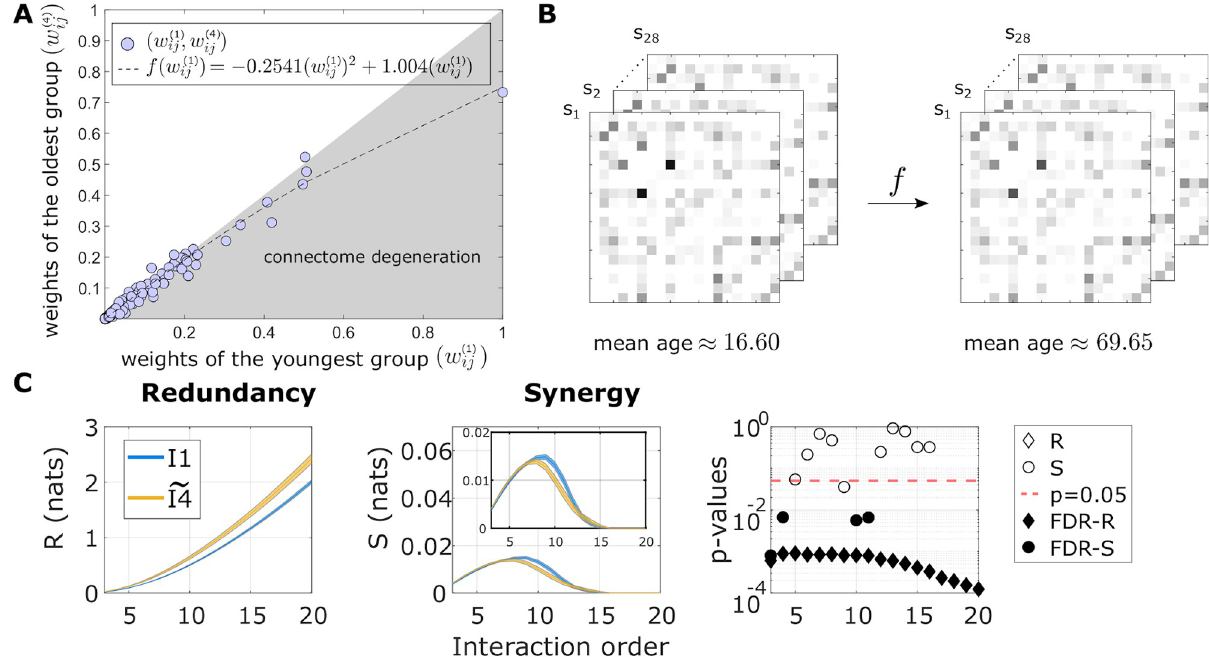
Fig 3. Connectome-based ageing model. A : A polynomial fit of second degree was used to link the weights of the average connectome within I1, , and the corresponding ones in I4 ( w ð 4 Þ ). B : (left) Twenty-eight empirical young connectomes are transformed by the second-order denoted by w ð 1 Þ ij ij polynomial fit, obtaining the synthetic aged connectomes (right). C : We simulated the DMF model of the aged connectomes and the optimal value G 4 . The O-information was assessed and separated into the total redundancy (left) and synergy (center). The third panel at the right corresponds to the p- values of the Wilcoxon rank-sum test after comparing the redundancy and synergy of the synthetic I4 group with the ones in I1. When the value of redundancy or synergy survived multiple-comparison correction, both the diamonds and circles were filled.